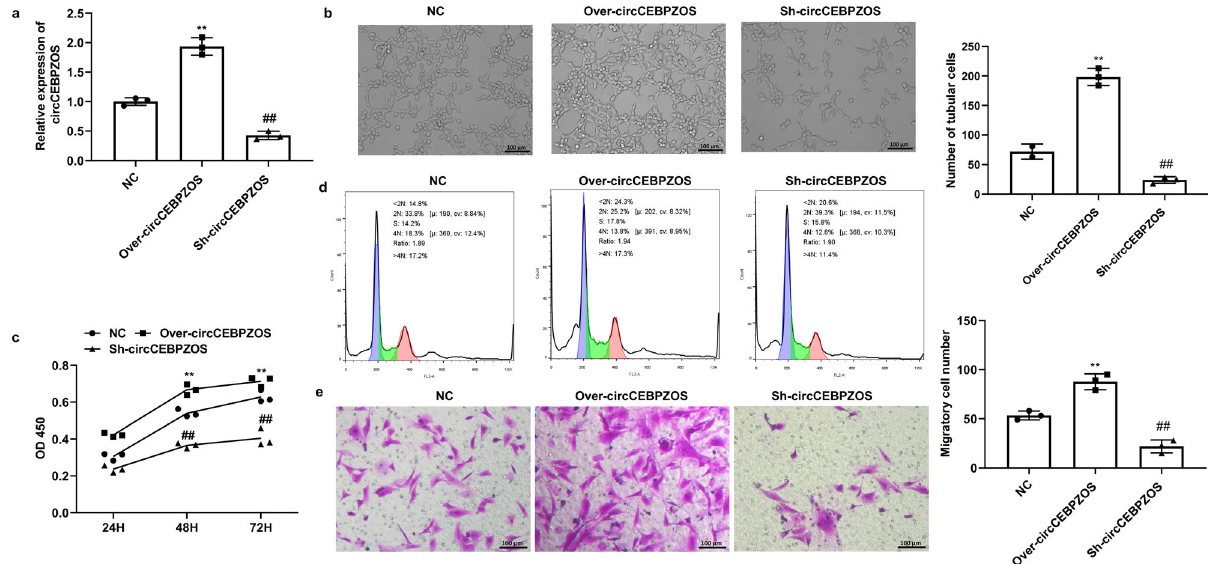
Fig. 3 circCEBPZOS promotes angiogenesis of CMECs and proliferation and migration of VSMCs. a qRT – PCR analysis was used to detect the expression of circCEBPZOS in the coincubation with EVs harboring with Over-circCEBPZOS or Sh-circCEBPZOS, GAPDH served as control; b Capillary-like structure analysis by tube formation assay in the Over-circCEBPZOS or Sh-circCEBPZOS group compared with the NC group, Bar = 200 μ m; c CCK-8 assay was used to detect the viability of VSMCs coincubated with exosomes harboring Over-circCEBPZOS or Sh-circCEBPZOS at 24 h, 48 h and 72 h; d Flow cytometry was used to detect the cell cycle of VSMCs coincubation with exosomes harboring with Over-circCEBPZOS or Sh-circCEBPZOS; e Transwell analysis was used to detect the migration of VSMCs coincubated with EVs harboring with Over-circCEBPZOS or Sh-circCEBPZOS, Bar = 200 μ m. Data are mean ± SD. ** p < 0.01, Over-circCEBPZOS group vs NC group; ## p < 0.01, Sh-circCEBPZOS vs NC